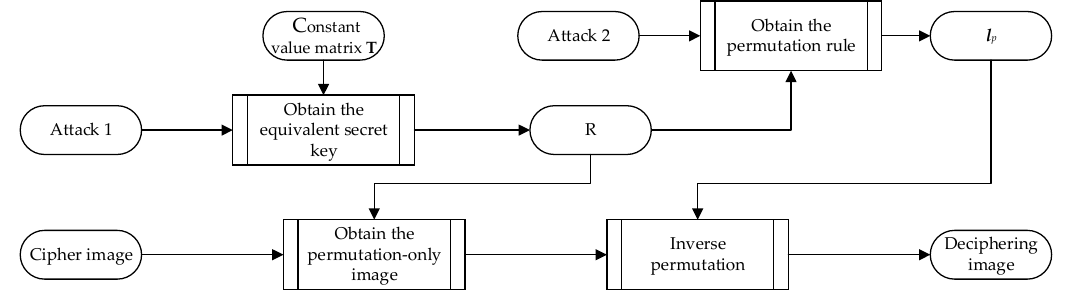
Figure 2. A framework of the proposed attack strategy.